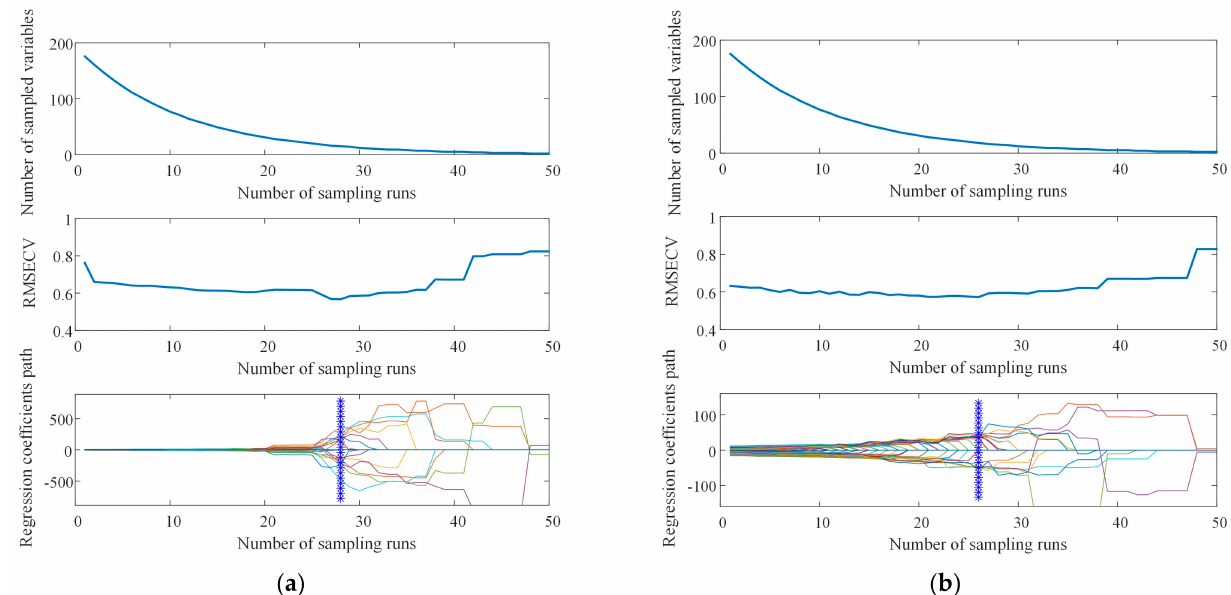
Figure 11. CARS Running results. ( a ) CARS wavelength selection after SNV preprocessing and ( b ) CARS wavelength selection after SNV-detrend preprocessing.